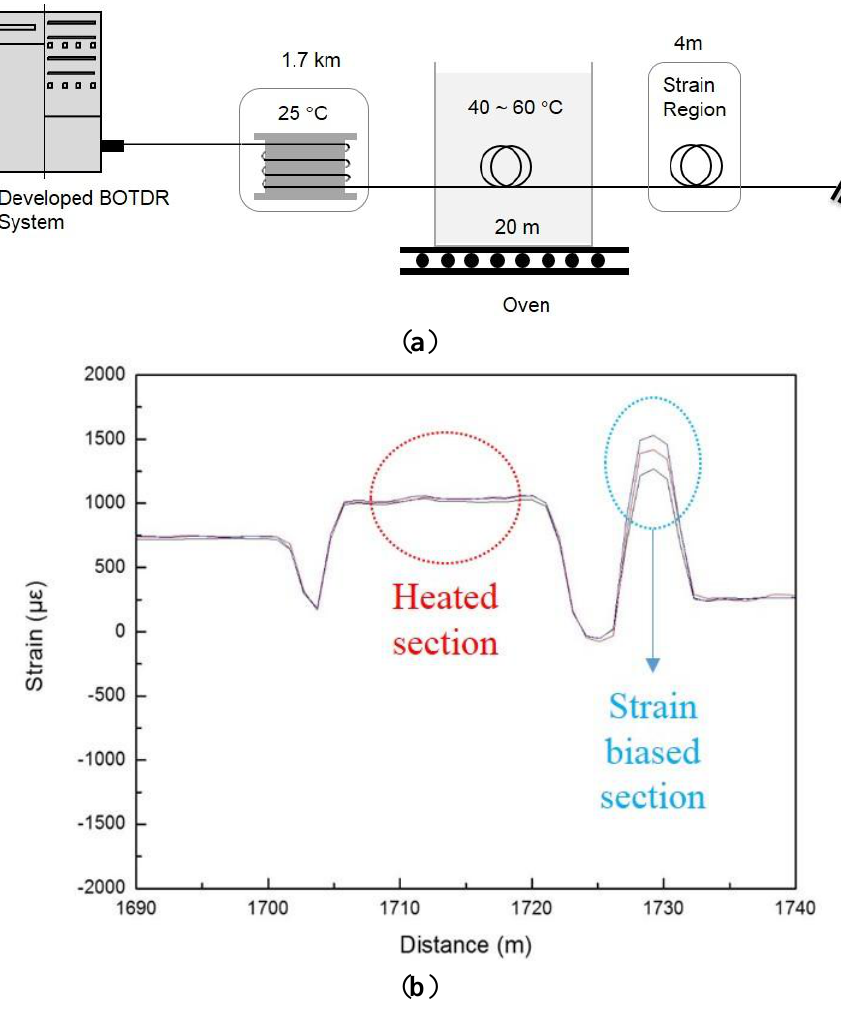
Figure 9. ( a ) Experimental setup for evaluating the strain measurement performance of the developed Brillouin OTDR system and ( b ) the result of the strain change profiles